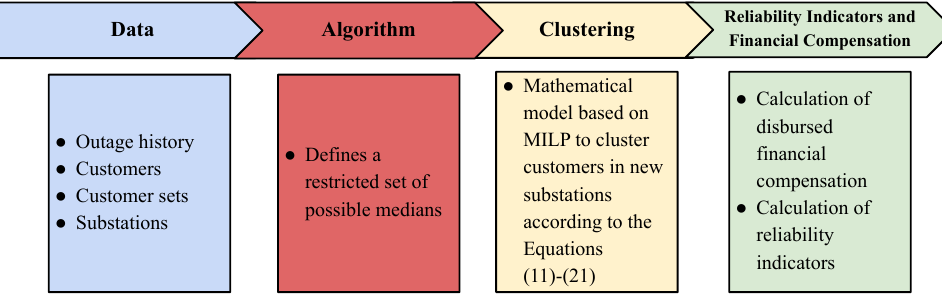
Figure 2. Overview of the proposed